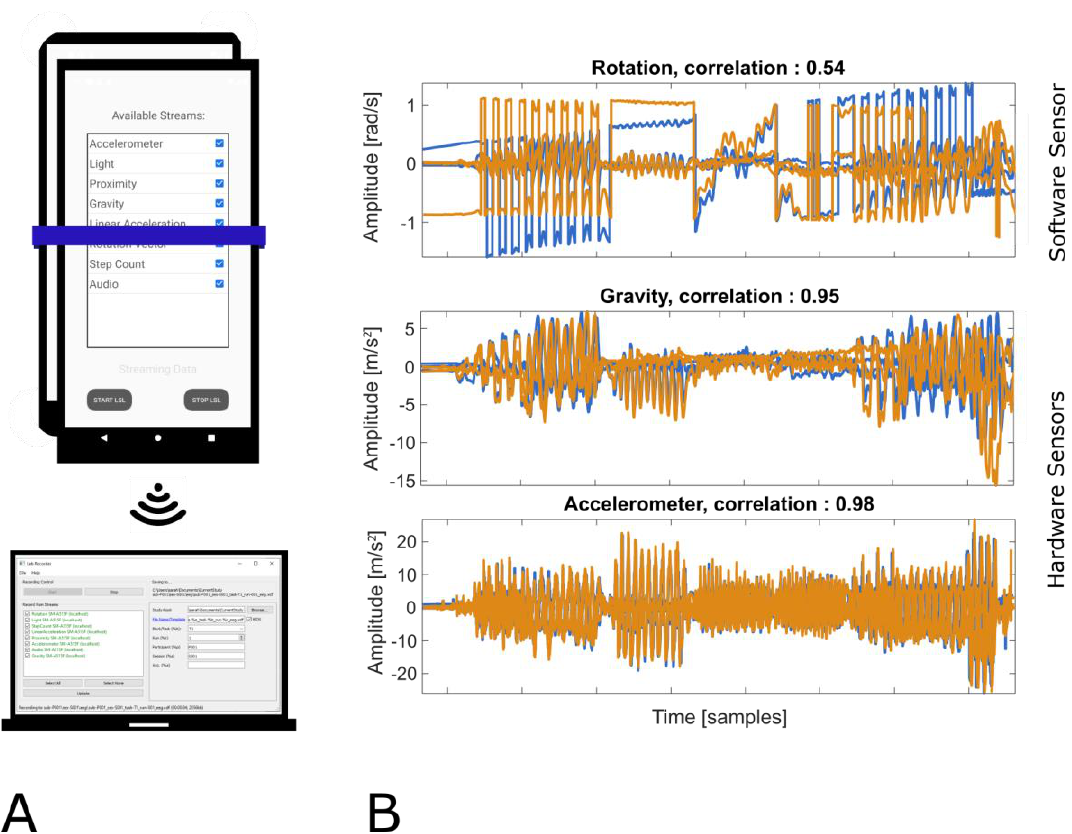
Figure 2. ( A ) Illustration of scenario 1B setup using sensor data as a data source. Two phones were moved together while Send-a was streaming sensor values. On PC, LabRecorder was recording all data streams to file. ( B ) Nine minutes of data recorded from three different sensors. Displayed is one channel for every sensor from phone 1 (blue) and phone 2 (orange).